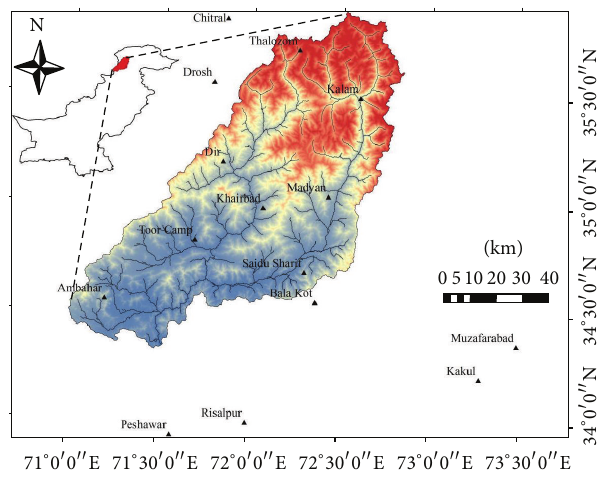
Figure 1: Physiographic features of Swat Basin and locations of rain gauge